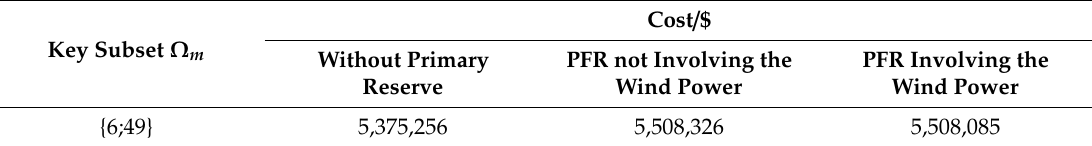
Table 1. Dispatch costs in di ff erent situations; PFR: primary frequency response.